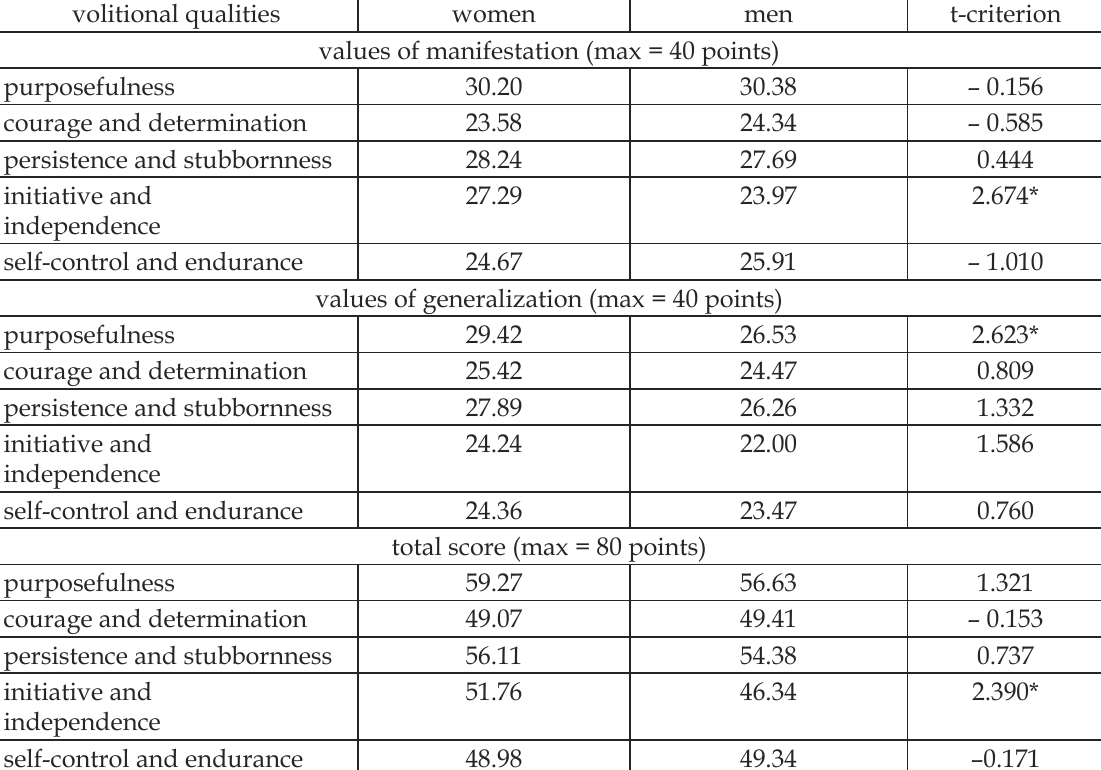
Table 2. Differences by gender in test results (t-criterion, that is statistically signi (cid:222) cant for the level of p <0.05, is marked with